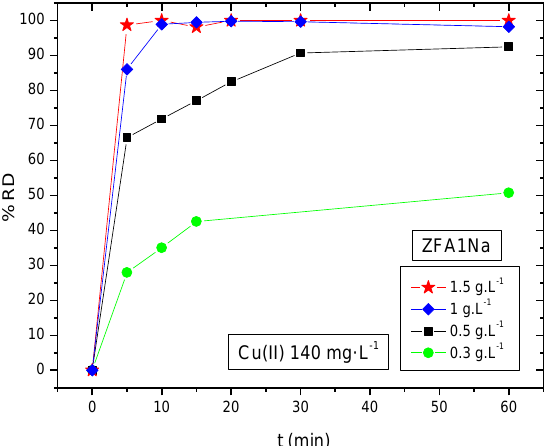
Figure 5. E ff ect of dosage (0.3–1.5 g · L − 1 ) on the removal e ffi ciency of ZFA1Na zeolite (initial Cu(II) Figure 5. Effect of dosage (0.3–1.5 g·L −1 ) on the removal efficiency of ZFA1Na zeolite (initial Cu(II) concentration of 140 mg · L − 1 ). concentration of 140 mg·L −1 ).